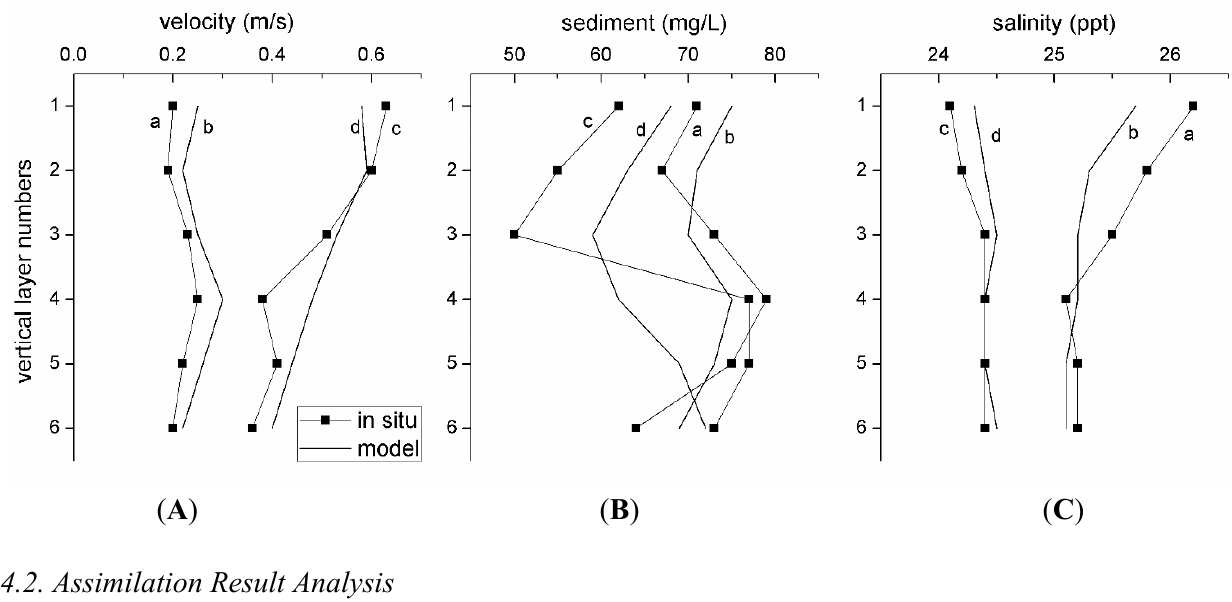
Figure 4. Vertical profile validation of model results at S7. ( A ) the current velocity at the maximum flood period at 11:00, on 17 October ( a , b ) and the maximum ebb period at 4:00, on 18 October ( c , d ); ( B ) the sediment concentration at the maximum flood period at 11:00, on 17 October ( a , b ) and the maximum ebb period at 4:00, on 18 October ( c , d ); ( C ) the salinity at the maximum flood period at 11:00, on 17 October ( a , b ) and the maximum ebb period at 4:00, on 18 October ( c , d ). Notes: a , c representing the measured profiles and b , d representing the simulated